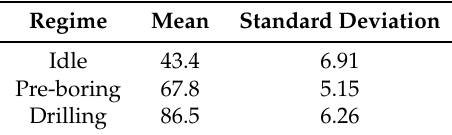
Table 2. Statistics of the identified